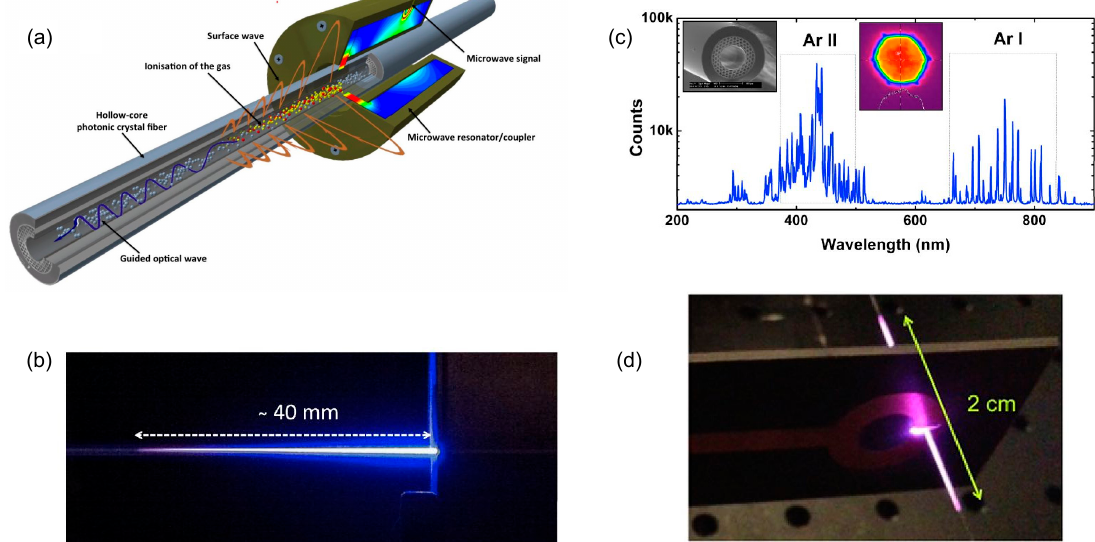
Figure 28. ( a ) Schematic representation of plasma column generation in HCPCF with a surfatron. ( b ) Side view picture of the generated 4-cm-long plasma column. ( c ) Measured spectrum lines at fiber output (reprinted with permission from Reference [27], OSA, 2013). ( d ) New microstrip split-ring resonator (MSRR) plasma column excitatory (reprinted with permission from Reference [127], OSA, 2016).